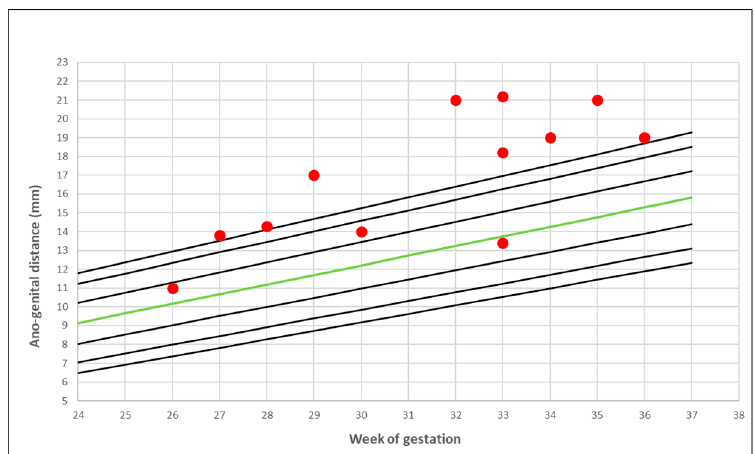
Figure 3. The ano-genital distance in PCOS mothers: female foetuses. The red marks represent the distribution of the measurements scattered over the 2.5–97.5th centiles for local normal reference range. The green line represents the 50th centile [22].